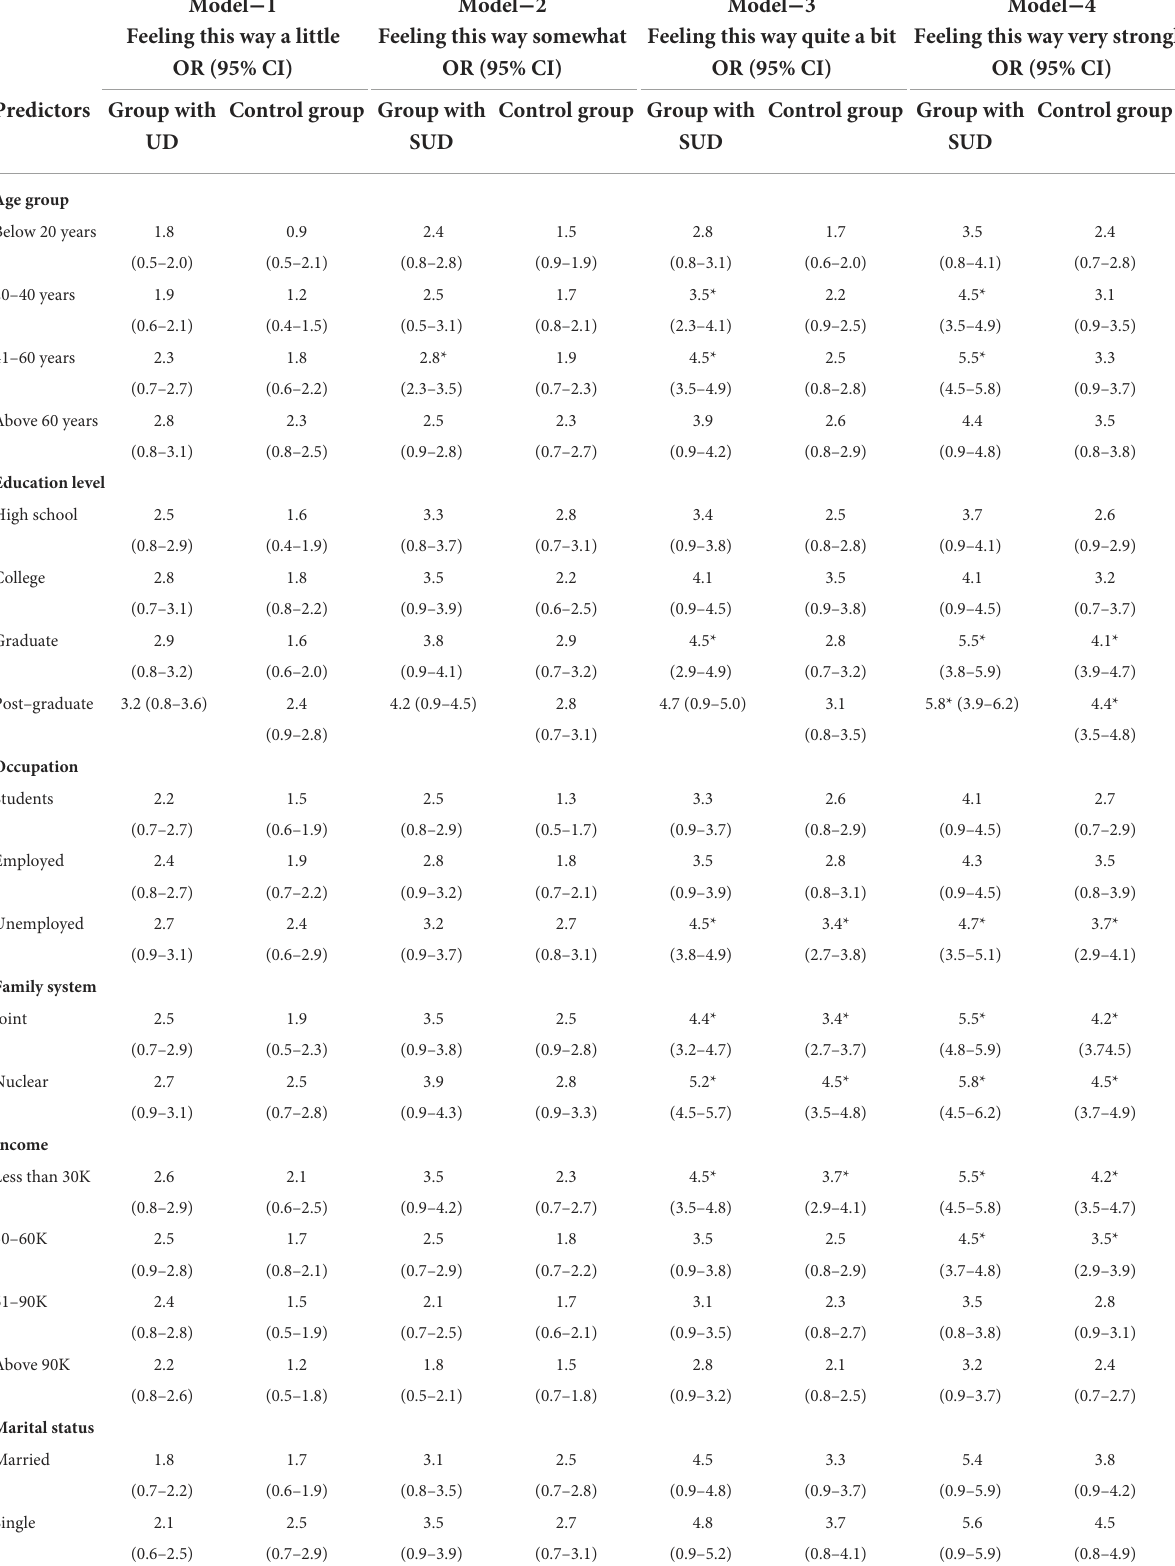
TABLE 5 Association of socioeconomic factors with different levels of guilt in group with SUD and control